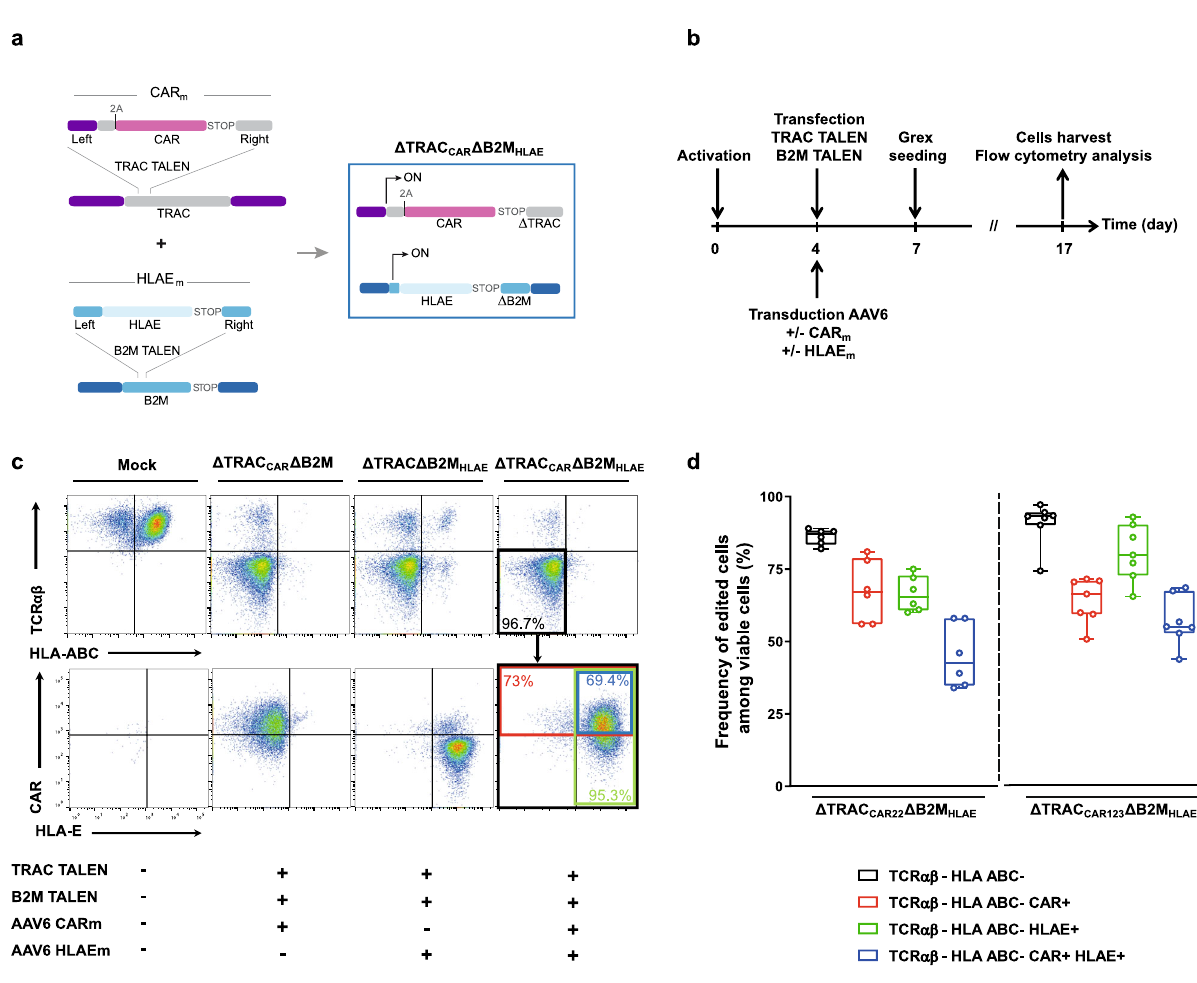
Fig. 1 TALEN-mediated multiplex editing enables ef fi cient CAR and HLA-E expression in TCR αβ /B2M double knockout T cells. a Schematic showing the editing strategy at the TRAC and B2M loci to generate Δ TRAC CAR Δ B2M HLAE T cells from wild-type T cells. b Experimental design for multiplex editing of TRAC and B2M loci using TALEN and adeno-associated viral (AAV6) particles and analysis of the resulting engineered T cells. c Representative fl ow- cytometry analysis of mock-transfected T cells and T cells engineered with different combinations of TALEN and AAV6 particles (CAR 123m and HLA-E m ) c , top panel, fl ow-cytometry plots showing the frequency of TCR αβ and HLA-ABC expression in viable engineered T cells. c bottom panel, fl ow-cytometry plots showing the frequency of CAR and HLA-E expression detected among TCR αβ ( − )/HLA-ABC( − ) viable engineered T cells. The black bold box depicts the parent population. d Box plot showing the frequency of different subpopulations detected in engineered Δ TRAC CAR22 Δ B2M HLAE T cells (left) and Δ TRAC Δ B2M CAR123 HLAE T cells (right). The gating strategy used to obtain the frequency of each subpopulation is illustrated by the black, red, green, and blue bold boxes in ( c ), right fl ow-cytometry panel). In each box plot, the central mark indicates the median, the bottom and top edges of the box indicate the interquartile range (IQR), and the whiskers represent the maximum and minimum data point. Each point represents one experiment performed with a given donor ( n = 6 for Δ TRAC CAR22 Δ B2M HLAE and n = 7 for Δ TRAC CAR123 Δ B2M HLAE ). Source data are provided as a Source Data fi